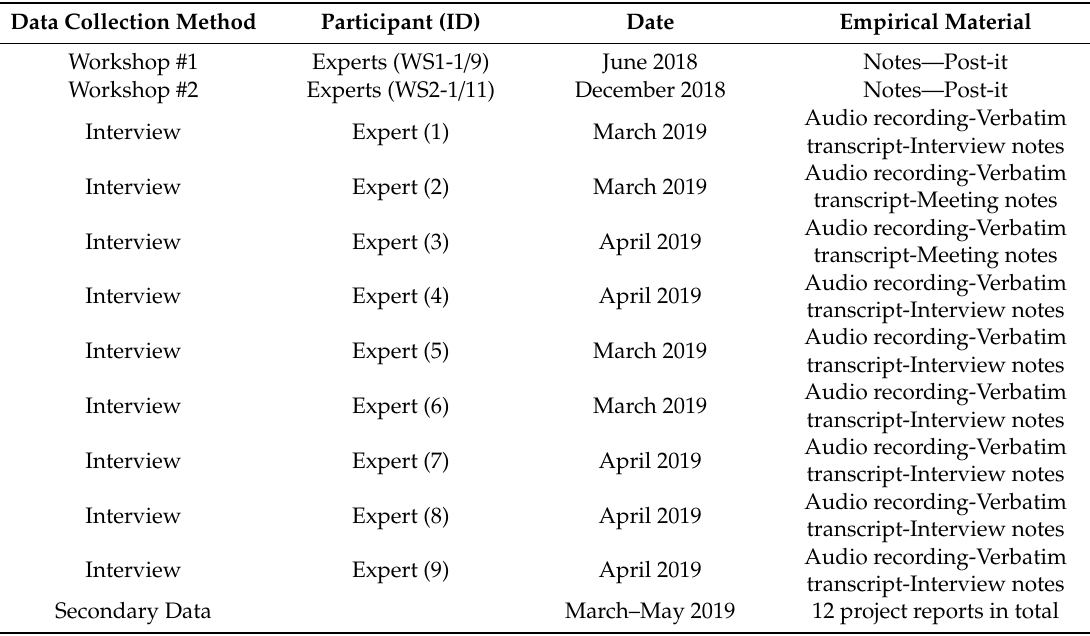
Table 5. Summary of data